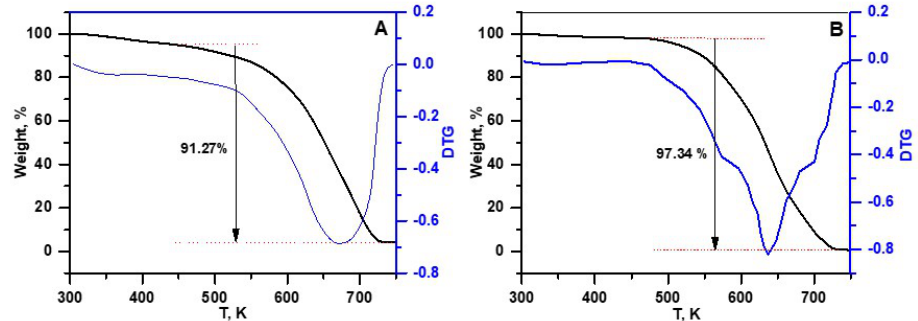
Figure 1 . TGA and DTG of ( A ) poly(EDMA) and ( B )